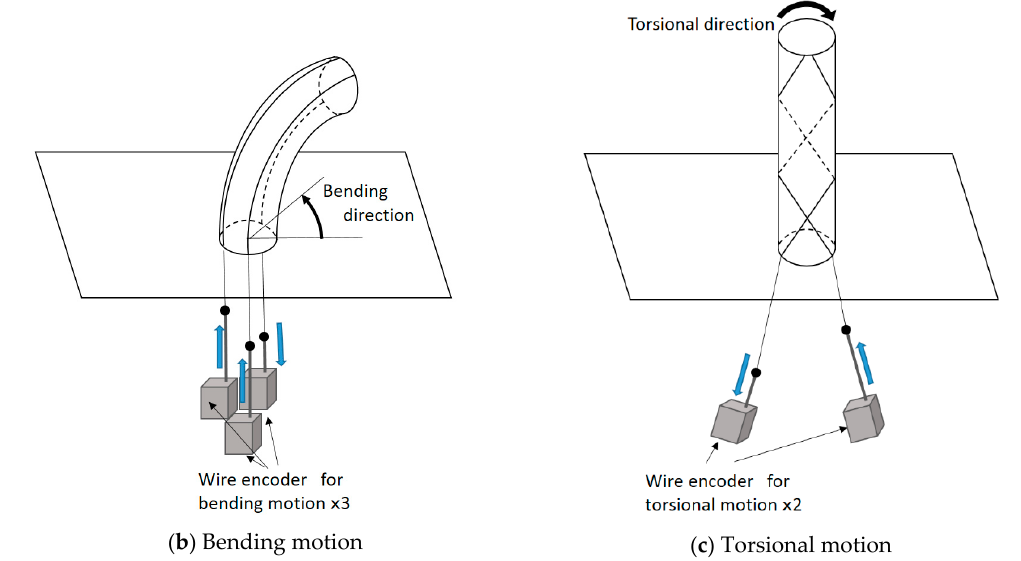
Figure 10. Sensing principle of the soft robot arm motion by wire encoders: ( a ) Configuration of the sensing system. ( b ) Sensing principle for the bending motion. ( c ) Sensing principle for the torsional motion.